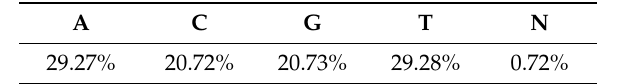
Table 2. Nucleotide base composition of the caribou genome assembly statistics of the caribou